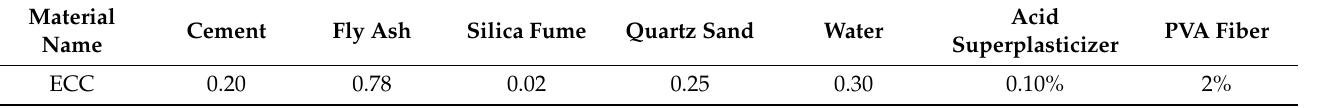
Table 3. Mixture proportions (kg/m 3 ).